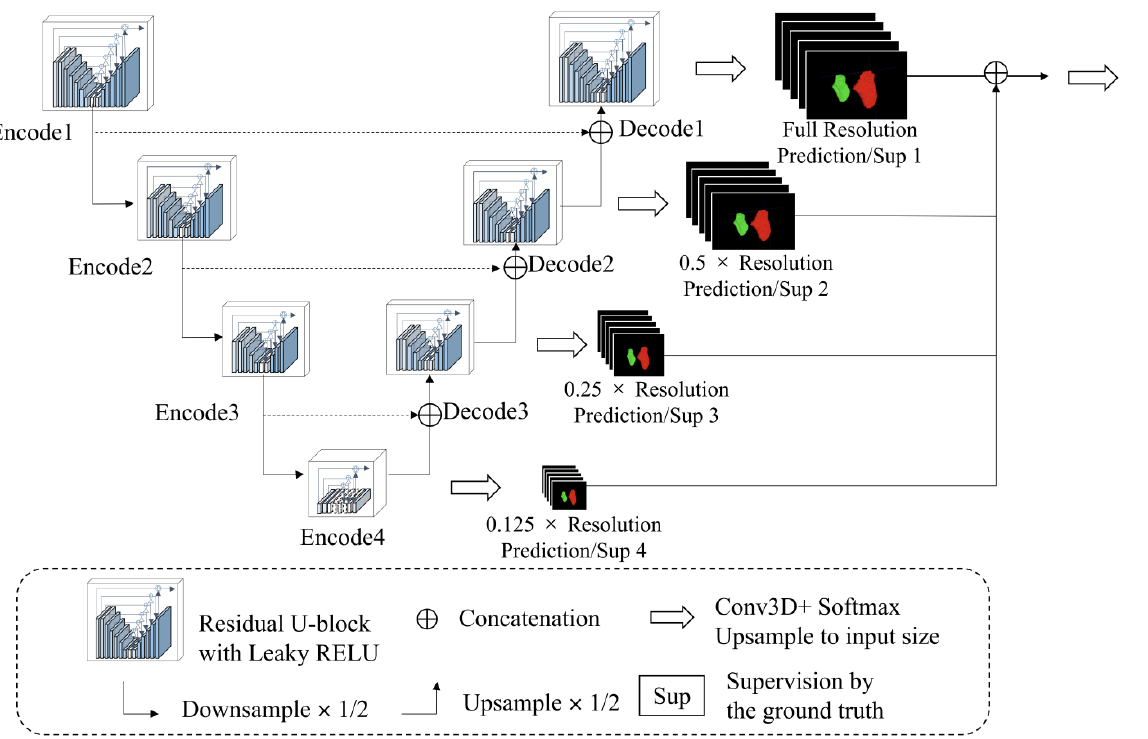
Figure 5. The architecture of the proposed model.